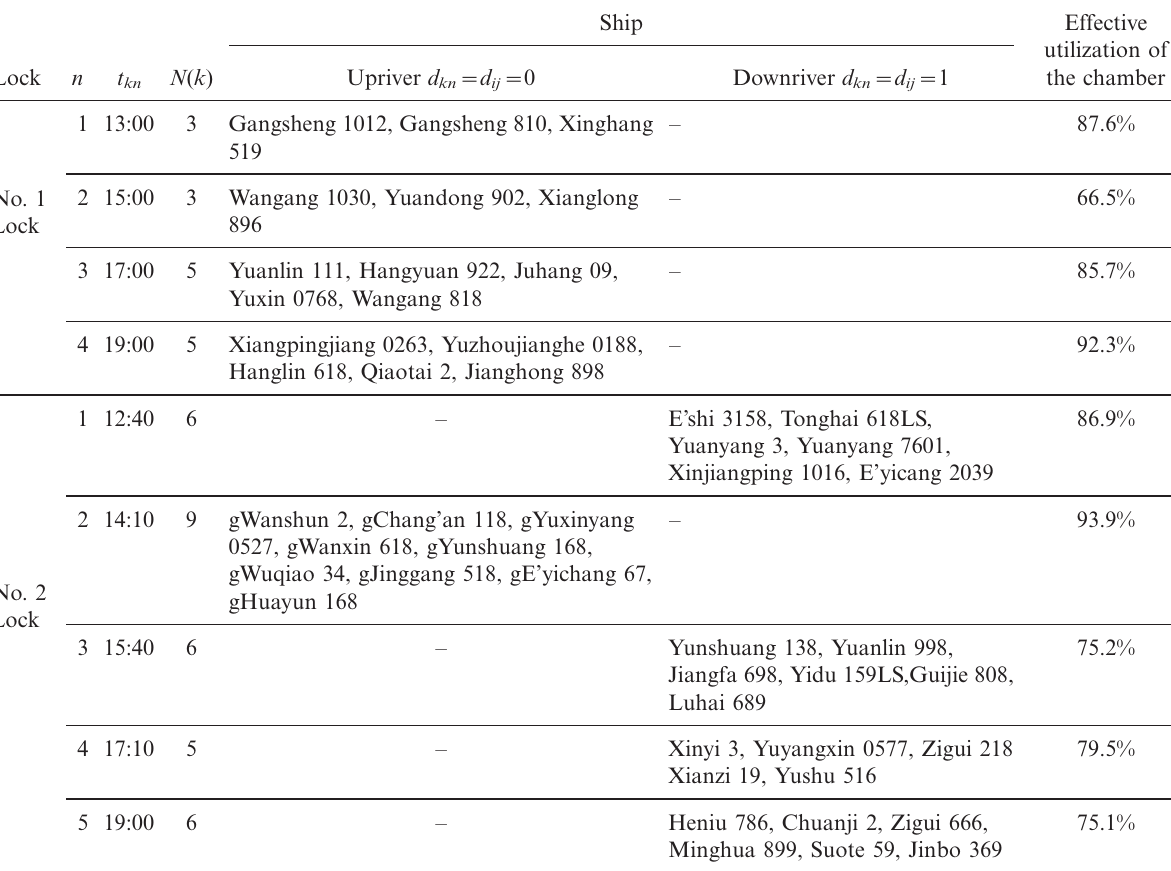
Table 4. 8 hours NCS of the Three Gorges Project on 25 November 2010 (11:00 am (cid:2) 19:00